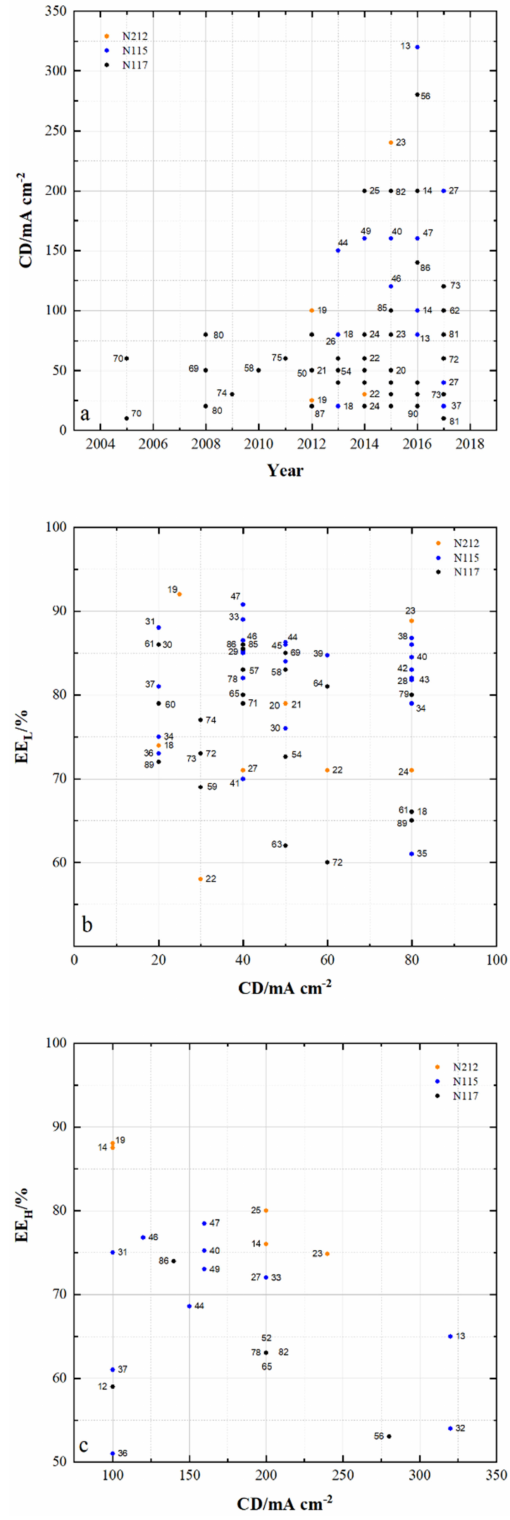
Figure 2. Results from VRFB tests using Nafion: ( a ) current density during cycling tests ( b ) energy efficiency of VRFB cells at current densities < 100 mA cm − 2 and ( c ) energy efficiency of VRFB cells at current densities ≥ 100 mA cm −